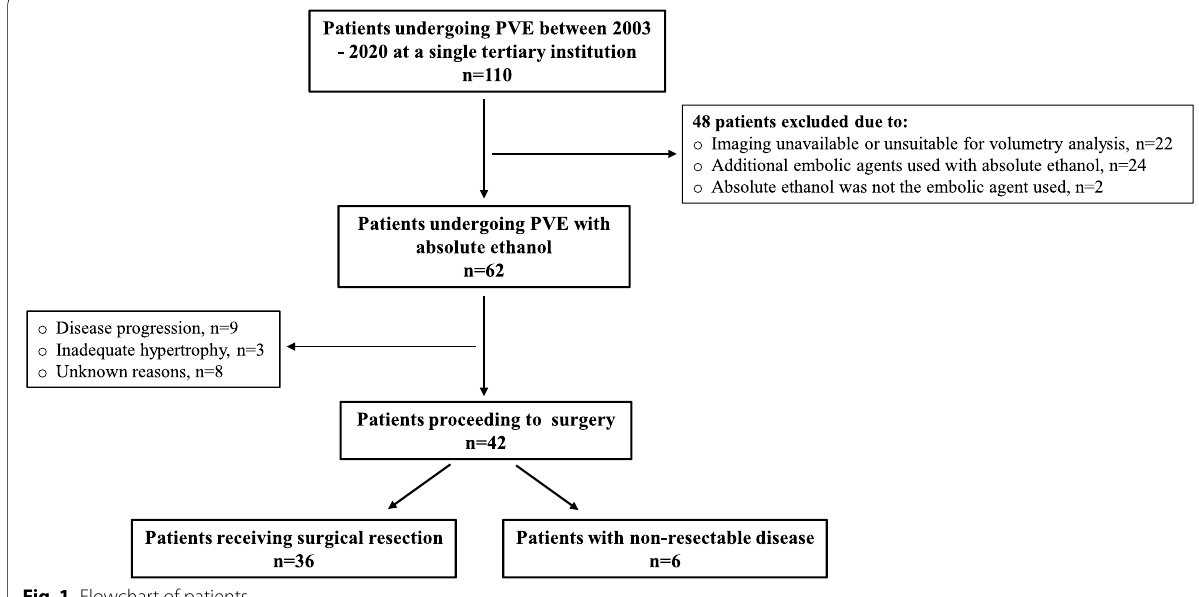
Fig. 1 Flowchart of